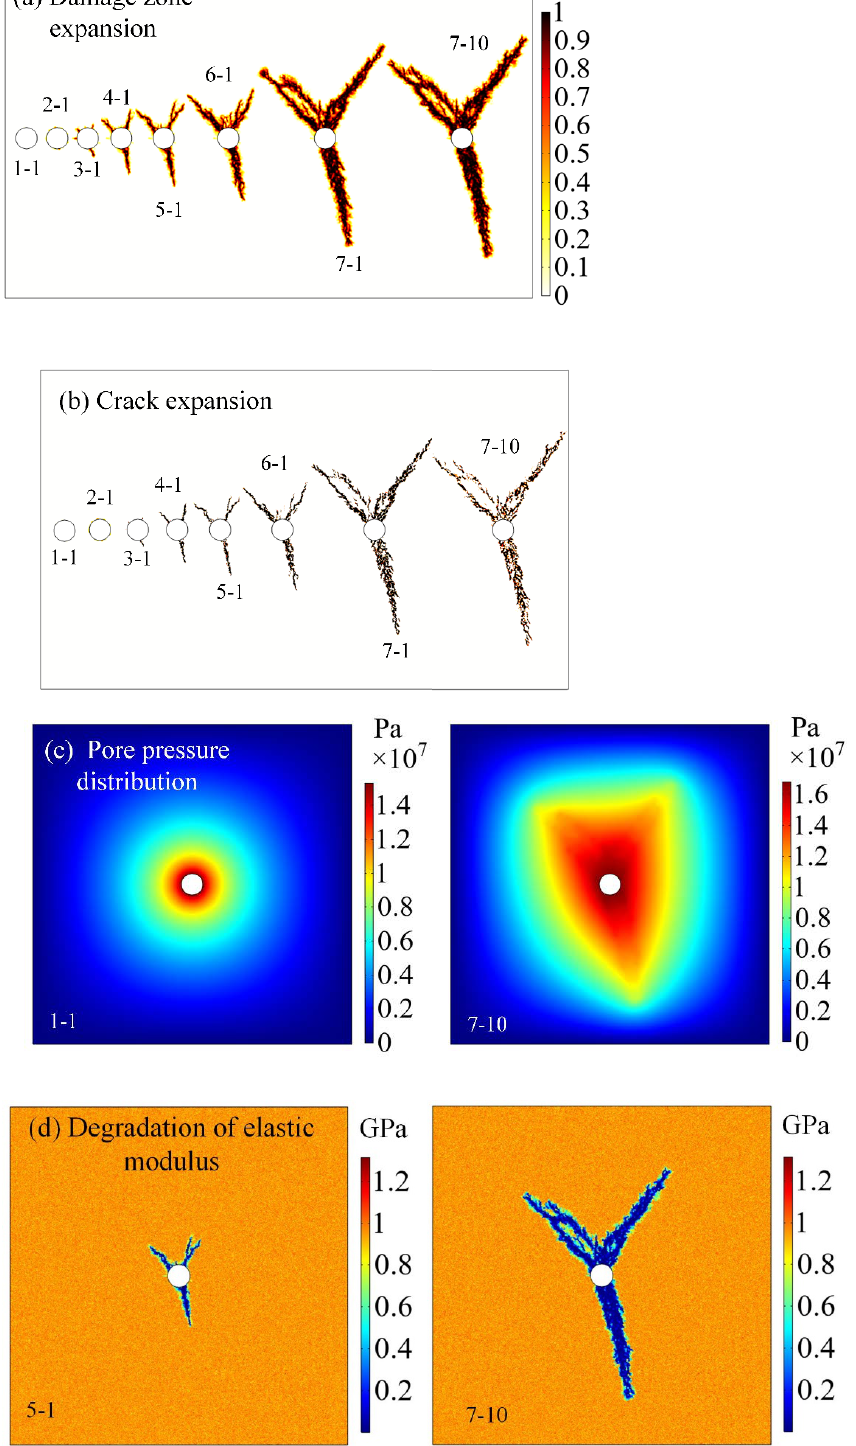
Figure 8. Damage zone expansion, crack expansion, pore pressure distribution and elastic modulus degradation law around hydraulic fracturing drilling when ξ = 1.0. (Note that: the color bar in Figure 8 ( a ) represents the damage variable, D ; the color bar in Figure 8 ( b ) represents the crack expansion, ( c ) represents the pore pressure value; the color bar in Figure 8 ( d ) represents the elastic modulus value at different areas.).